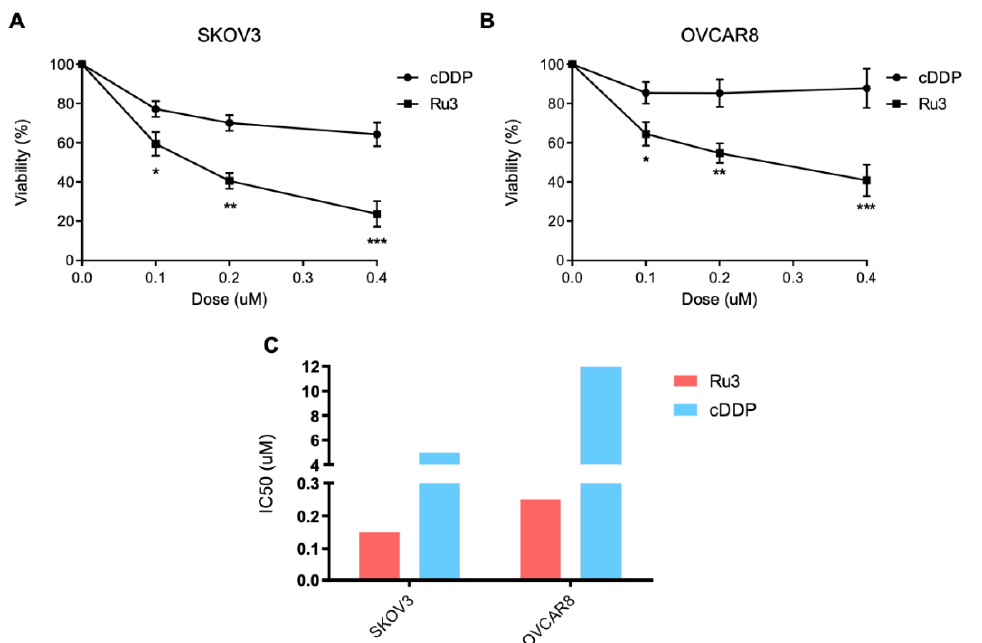
Figure 8. Ru3 is a putative therapeutic candidate for ovarian cancer treatment. Viability of two ovarian cancer cell lines, OVCAR8 and SKOV3, was assayed by MTT metabolization after 72 h treatment with Ru3 and cDDP, as a control, showing that Ru3 developed more toxicity in both cell line models ( A ) and ( B ), as IC 50 values demonstrate ( C ). Data are the average +/- standard deviation (SD) of three independent experiments performed in triplicate. To determine significant statistical differences, Student ’s t -test was used. The values for the statistical analyses are: *, p ≤ 0.05; **, p ≤ 0.01; ***, p ≤ 0.001.